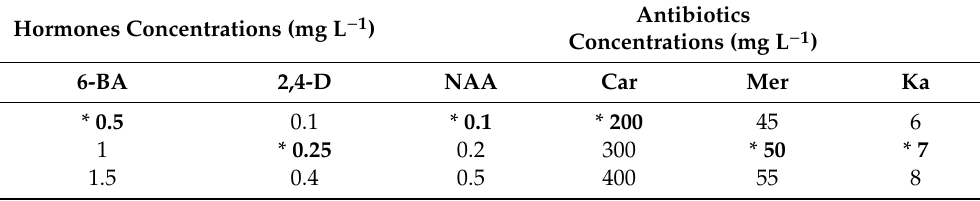
Table 1. Various concentrations of hormones and antibiotics used in MS medium for chrysanthemum